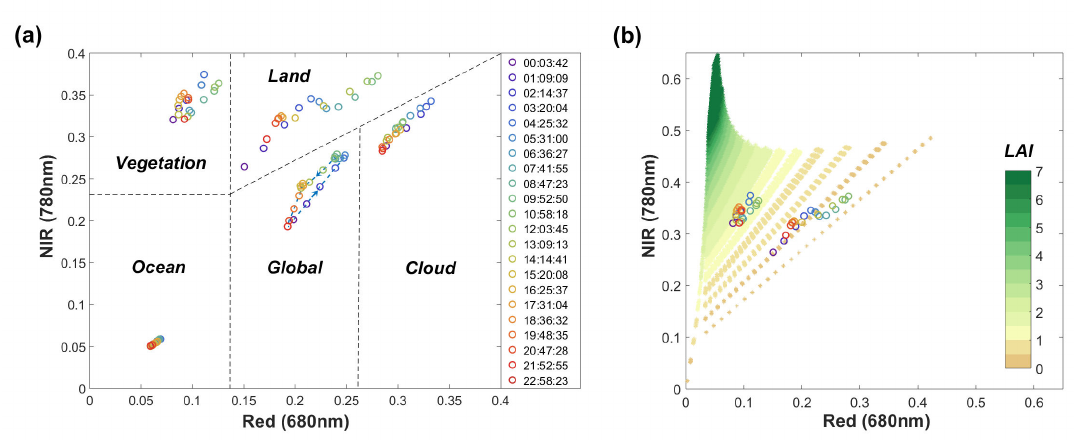
Figure 5. ( a ) Diurnal course of the scattering function on the near infrared (NIR) vs. red spectral plane (block “global”). The blocks “cloud,” “ocean”, “land” and “vegetation” show the trajectories of the mean scattering function over cloudy and cloud-free ocean, land, and vegetated pixels, respectively. ( b ) Domain of variation in red and NIR reflectance of bare and vegetated land simulated with the stochastic radiative transfer equation. SZA = 0 ◦ ~15 ◦ , phase angle = 0 ◦ ~9 ◦ . Lines show leaf area index (LAI) isolines (i.e., LAI is constant while soil reflectance varies). Circles are points from the blocks “vegetation” and “land”. DSCOVR EPIC images taken on 23 August 2016 (https://epic.gsfc.nasa.gov/ ?date=2016-08-23) were